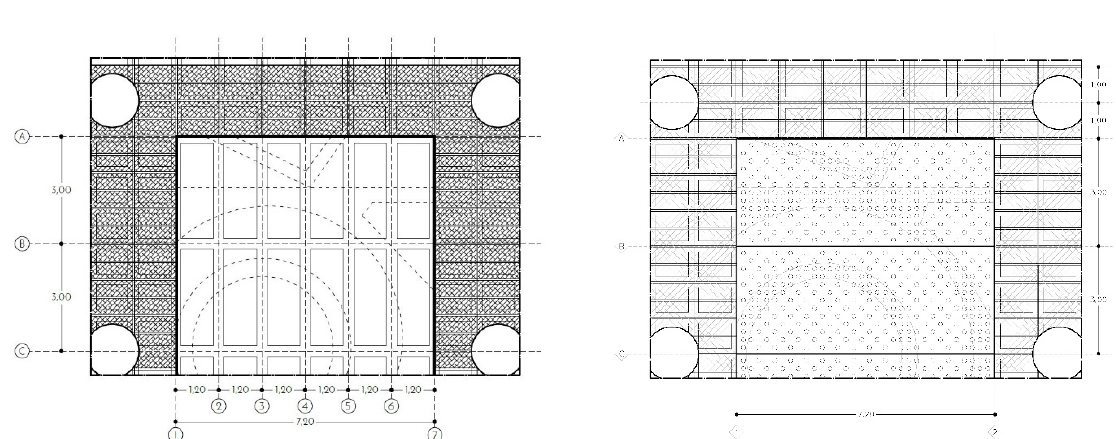
Fig. 9: sketches of the design intent